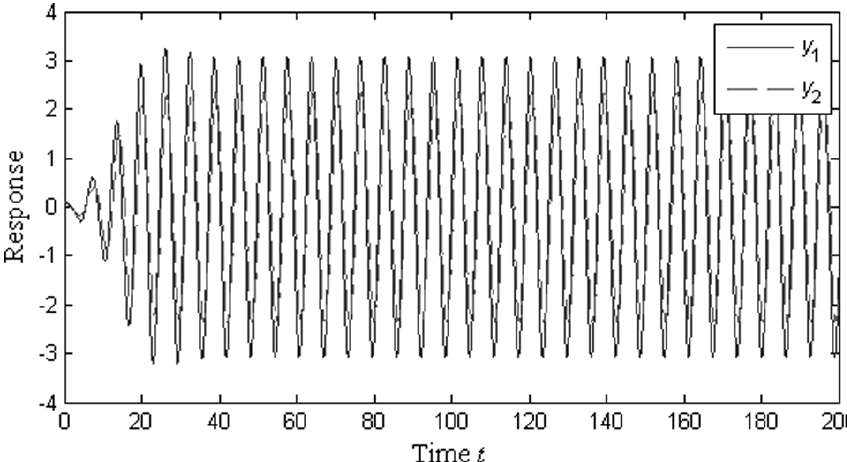
Fig. 24. Time history with feedback control, τ = 0, β 11 = β 12 = β 21 = β 22 =